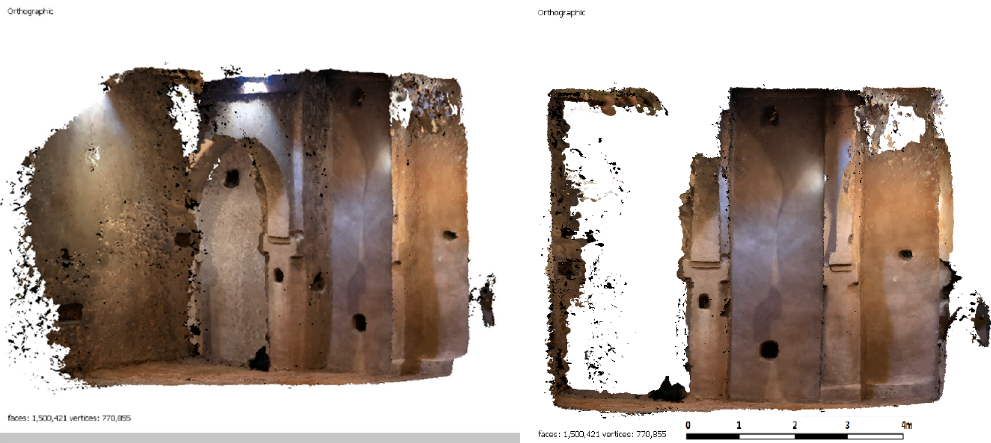
Figure 13. Point cloud created using Metashape software; a test with mobile phone camera (iPhone 7)—it was not a goal to make a photogrammetric model because we had other devices and there was no lighting equipment or a tripod at our disposal. Table 3. Comparison of the instruments used for the synagogue in the